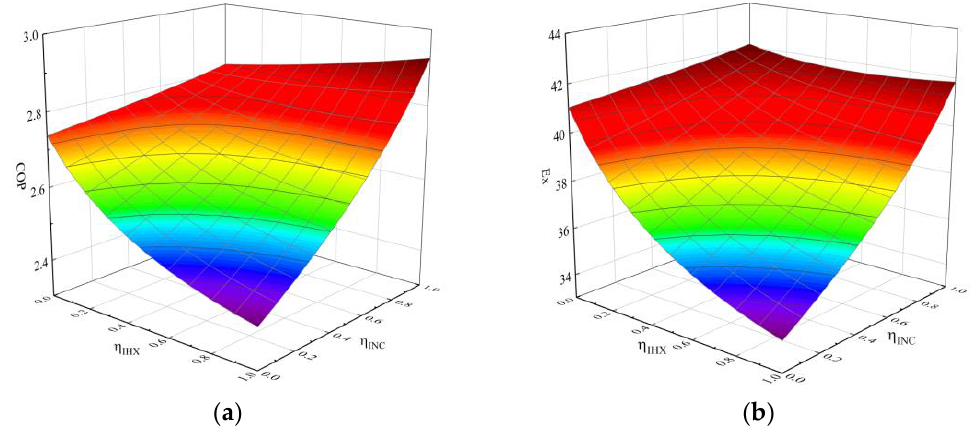
Figure 9. Three-dimensional plot of η IHX and η Inc on system performance: ( a ) Variations of COP; ( b ) Variations of the exergy efficiency.